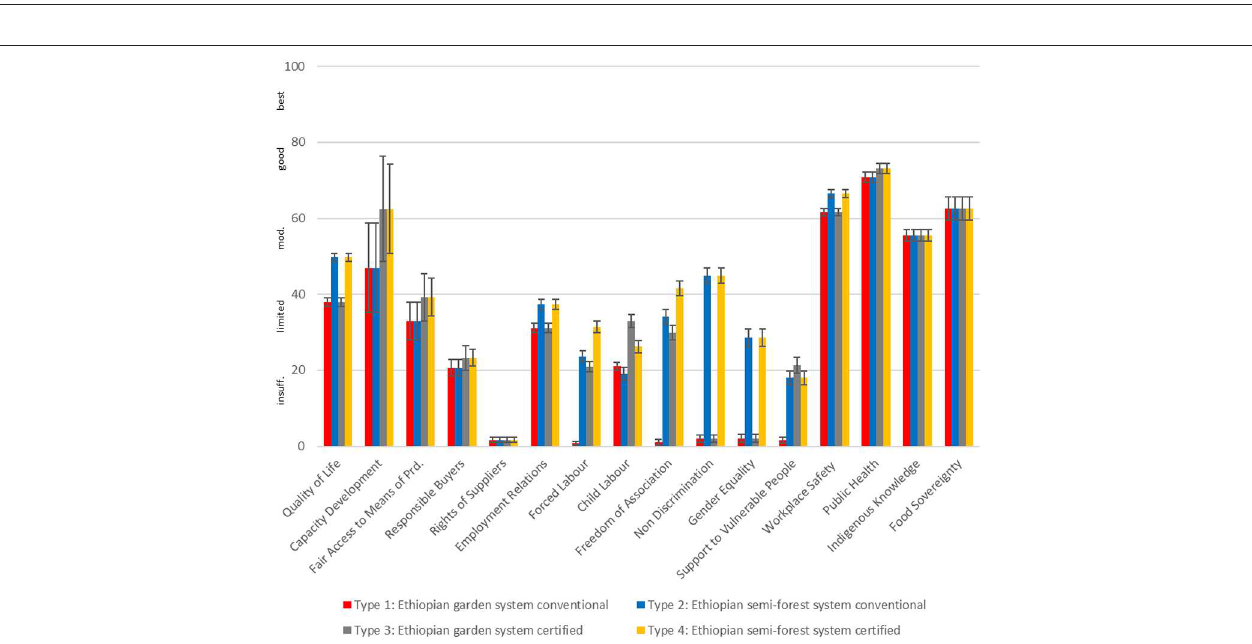
FIGURE 5 | Sustainability performance of typical Brazilian coffee production systems in “Economic Resilience”.